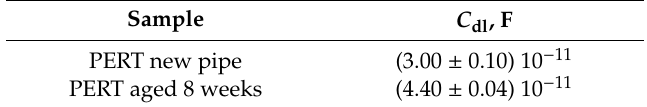
Table 3. C dl values for the di ff erent tested samples: new pipe and aged for 8 weeks.